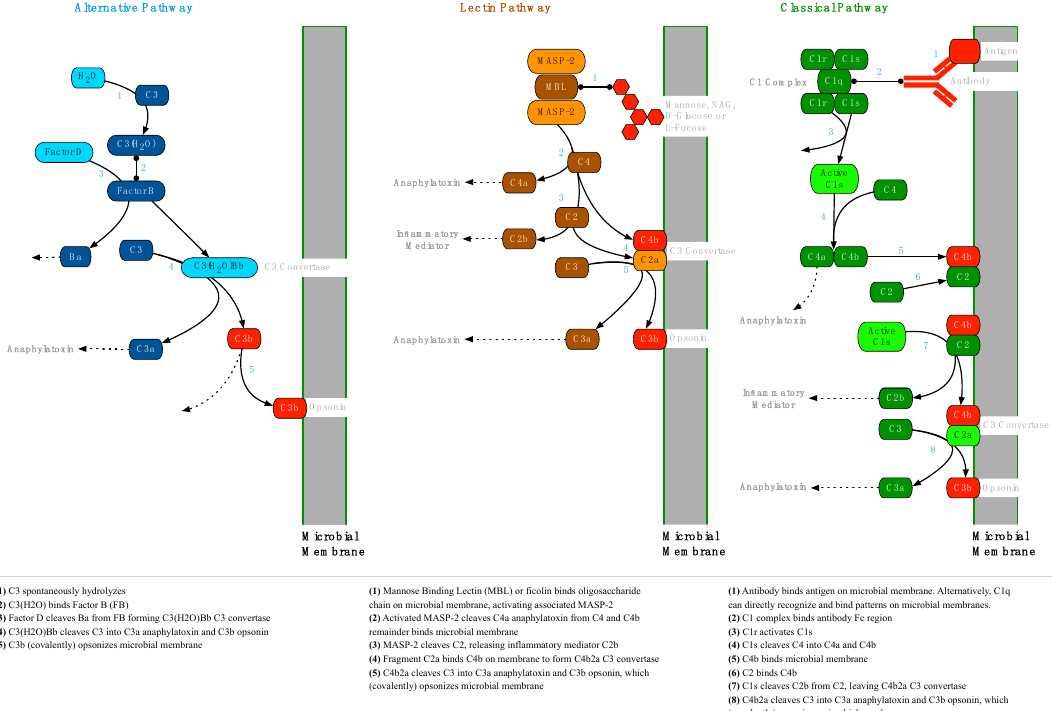
Figure 6. Microbial Opsonization via the Alternative, Lectin and Classical Pathways—To establish infection in a vertebrate host, Borrelia must first overcome the constitutive alternative and lectin pathways, and later the classical pathway. The initial stages of each complement pathway leading to (covalent) opsonization by C3b (shown here) are unique, but then converge into a single common pathway to form a membrane attack complex (Figure 7) [37] .